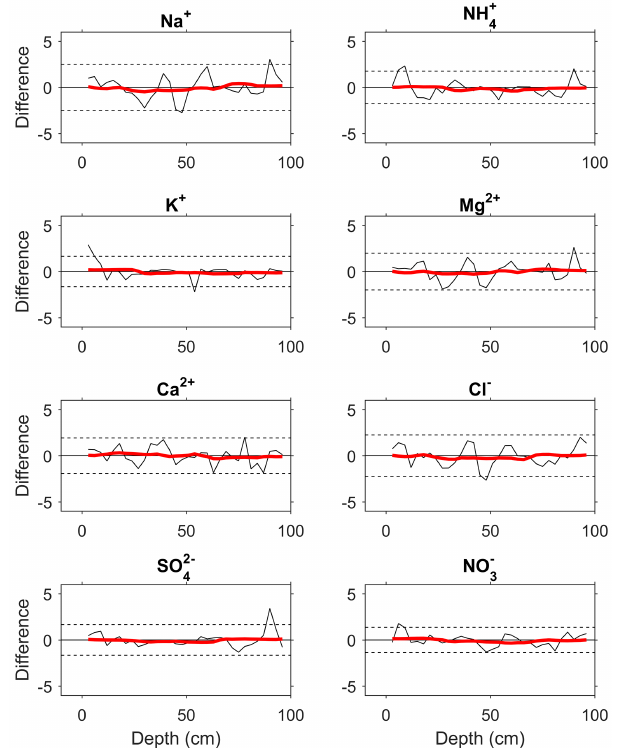
Figure 12. Difference between the normalized ionic concentrations ( c N ) in the snow pit sampled in 27 and 1 July 2012. Twice the stan- dard deviation and zero values are also shown. Deposition is a pos- itive excursion and elution zones are negative excursions from the mean in each diagram.